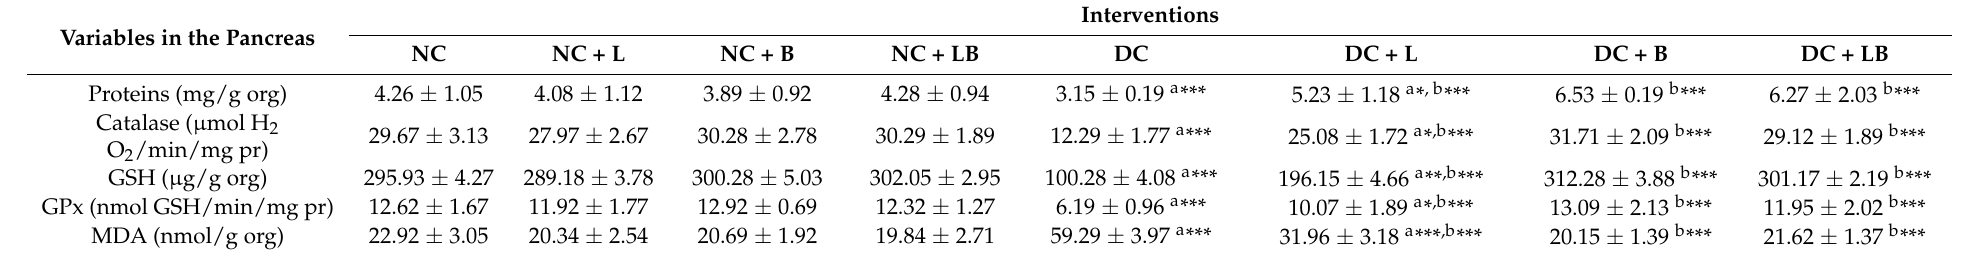
Table 6. Effect of the interventions on the oxidative parameters in the pancreas (mean ± SD). Variables in the